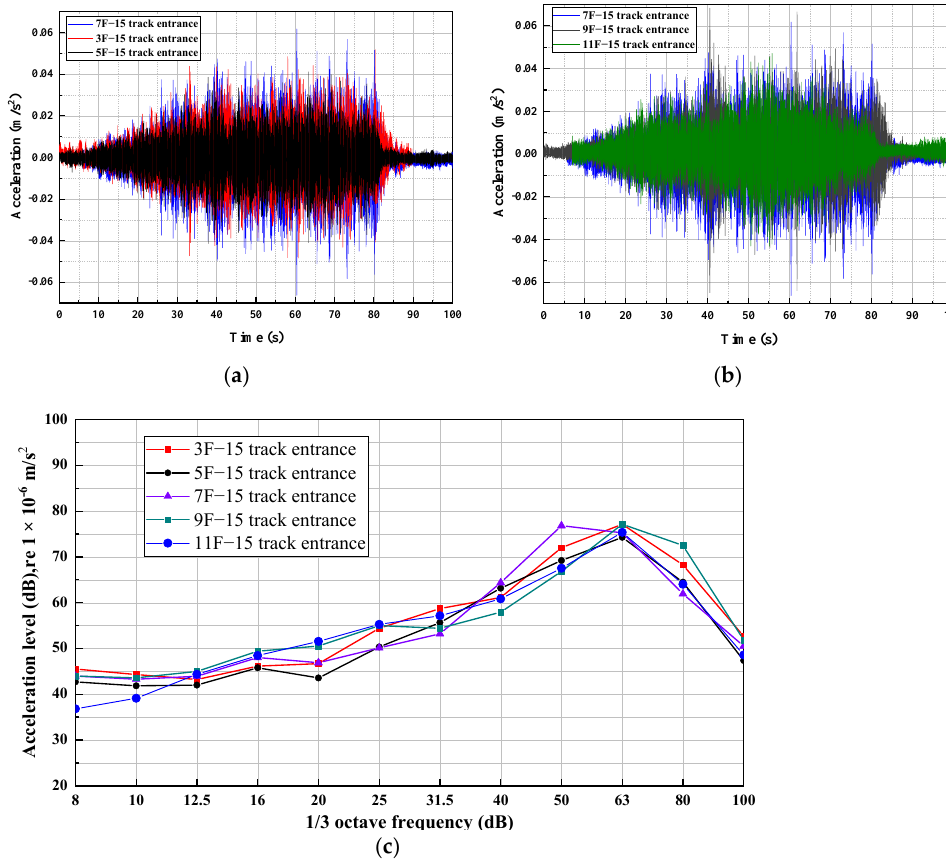
Figure 9. Analysis results of the vibration effect on human comfort on different floors in the time and frequency domains when the train enters track 15. ( a ) Time domain diagrams of measurement points on the 3rd, 5th and 7th floors; ( b ) Time domain diagrams of measurement points on the 7th, 9th and 11th floors; ( c ) One-third octave frequency diagrams of measurement points on the 3rd, 5th, 7th, 9th, and 11th floors.